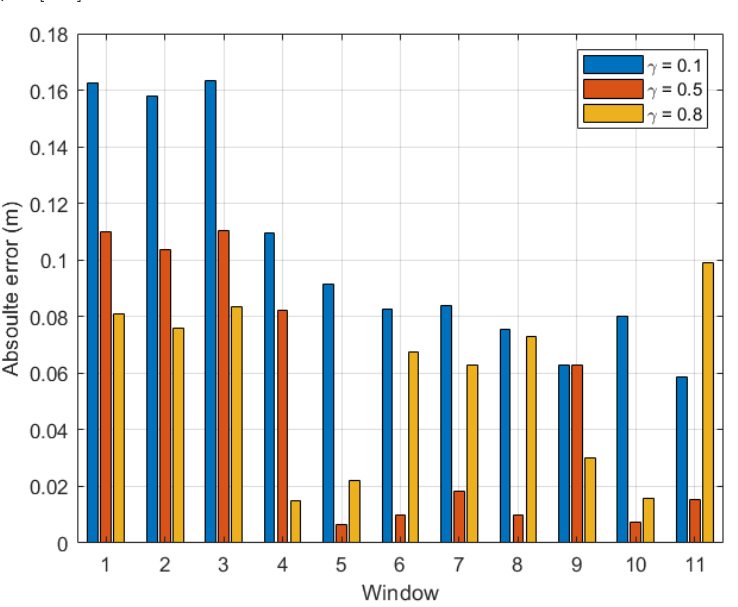
Figure 12. Outdoor walking (dataset 4): absolute error with respect to time windows tw i , i ∈ [ 1,11 ]